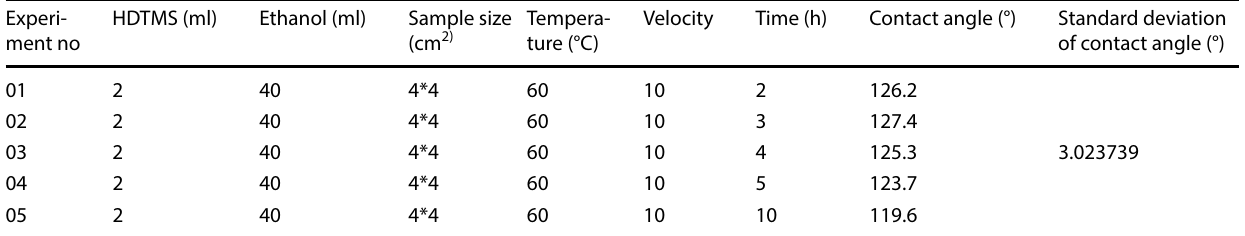
Table 5 Different contact angle for different stirring time within same parameters Experi- ment